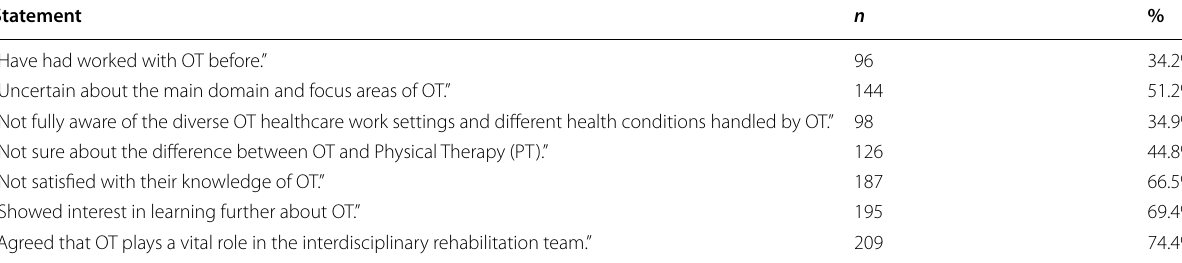
Table 2 Participants’ responses ( N